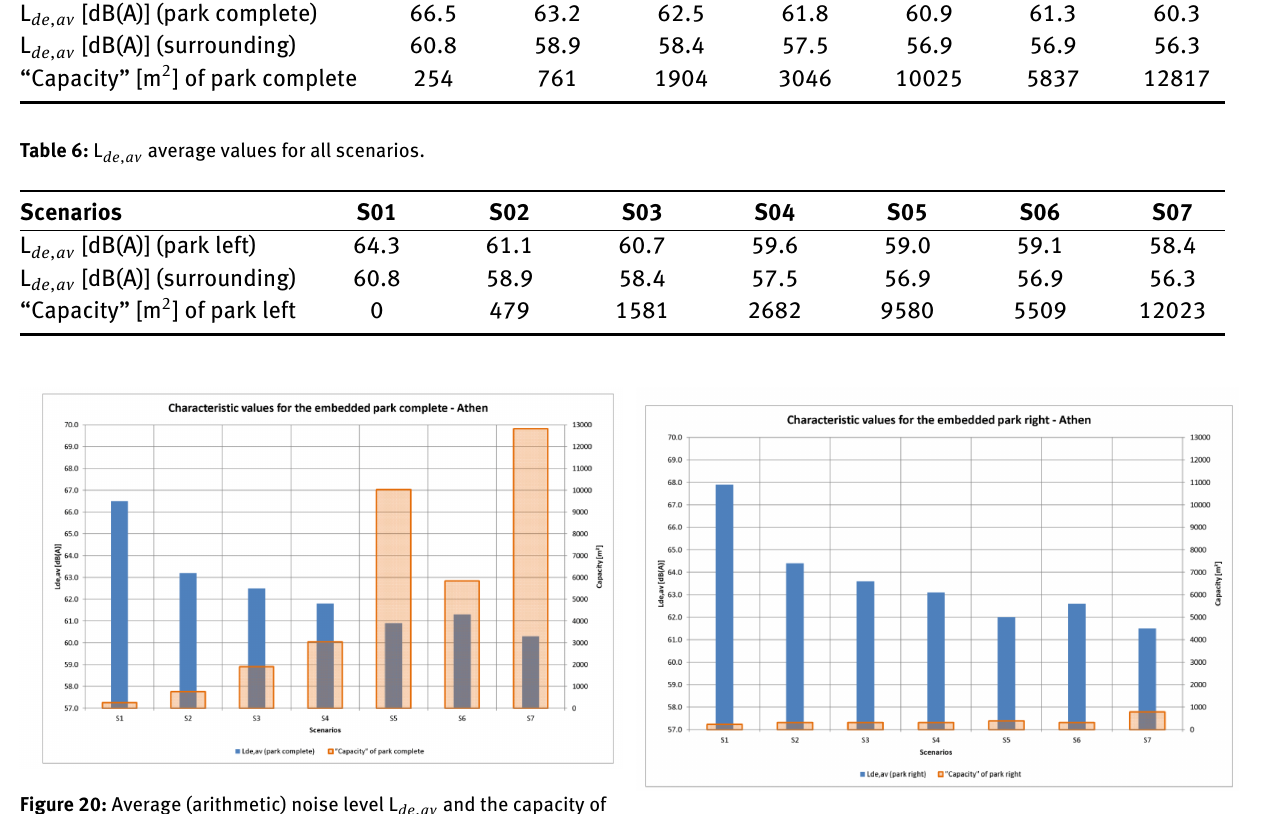
de , av and the capacity